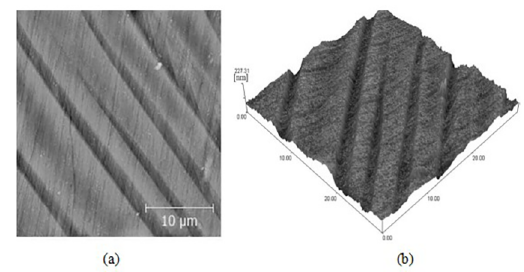
Figure 11. AFM images of a sample that has been subjected to 1 loading/unloading cycle for alloy Cu-11.8Al-0.6Be-0.5Nb (wt.%) at a temperature of 25 ºC. (a) 2D. (b)